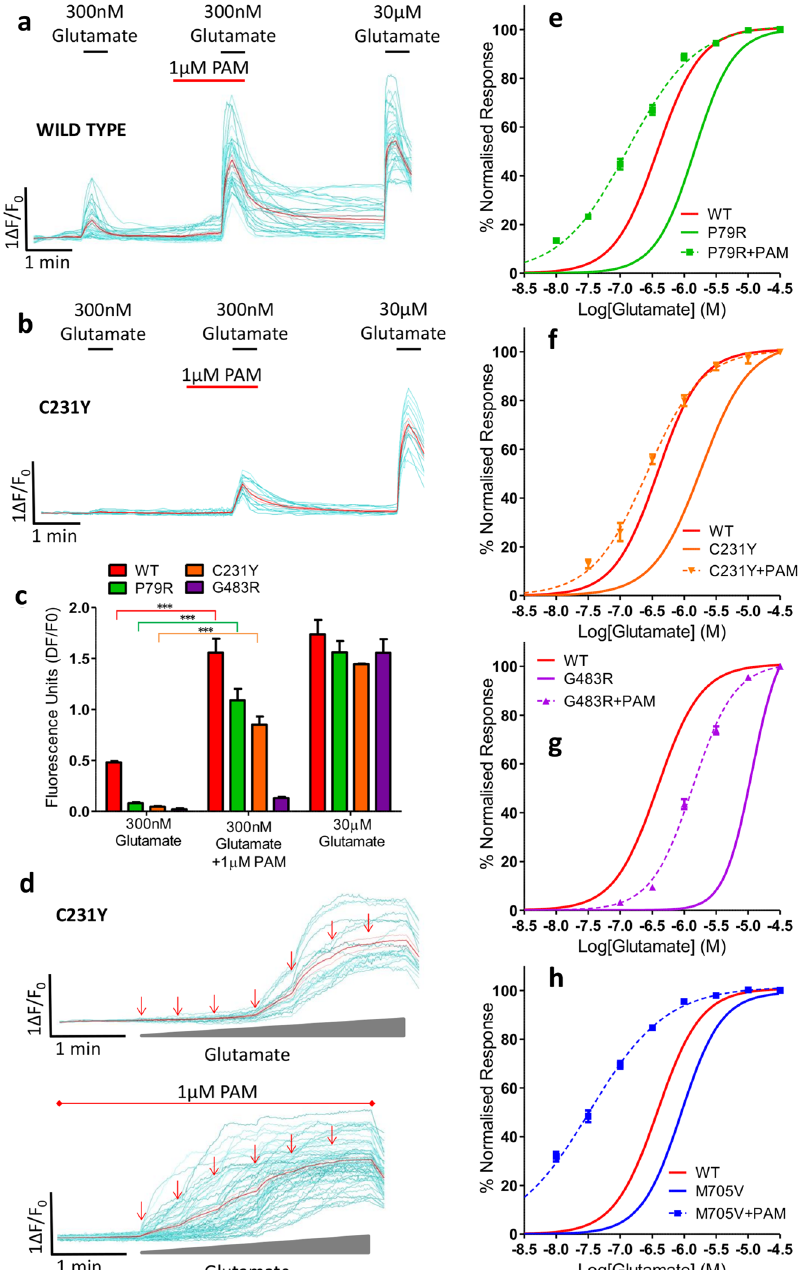
Figure 6. Pharmacological rescue of functional deficits can be achieved for selected GRIN2A mutants. Examples of single-cell imaging of HEK transfected with (a) WT and (b) C231Y mutant showing calcium- influx response to 300 nM glutamate before and after incubation with 1 µ M PAM and in comparison to maximal 30 µ M glutamate. (c) Graph of single cell imaging data showing response of WT and mutants P79R, C231Y and G483R to 300 nM glutamate with and without 1 µ M PAM. Bonferroni corrected ANOVA *** p < 0.001, n = 15 wells (over 3 assays) for each construct, 3 × 10 4 cells/well. Mean ± SEM. (d) Examples of single cell imaging of HEK transfected with C231Y mutant showing calcium-influx response to increasing concentrations of glutamate (30 nM, 100 nM, 300 nM, 1 µ M, 10 µ M and 30 µ M arrows) top, and below, increasing concentrations of glutamate (30 nM, 100 nM, 300 nM, 1 µ M and 30 µ M arrows) with constant 1 µ M PAM. Individual cell traces displayed in cyan and the mean response shown in red. (e–h) Concentration response curves of mutant (P79R, C231Y, G483R or M705V) GRIN2A transfected in HEK cells to increasing concentrations of glutamate (30 nM to 30 µ M) during incubation with 1 µ M PAM recorded from single-cell calcium-flux imaging. Each graph shows the response of the WT GRIN2A construct with no PAM in red (curve from Fig. 3c) and the response of the mutant before (solid line) and after (dashed line) the addition of PAM. p < 0.0001 for LogEC 50 for each construct + PAM when compared to without PAM addition. Data averaged from n = 12 wells for each construct, 3 × 10 4 cells/well, (over 3 assays). Error bars ±